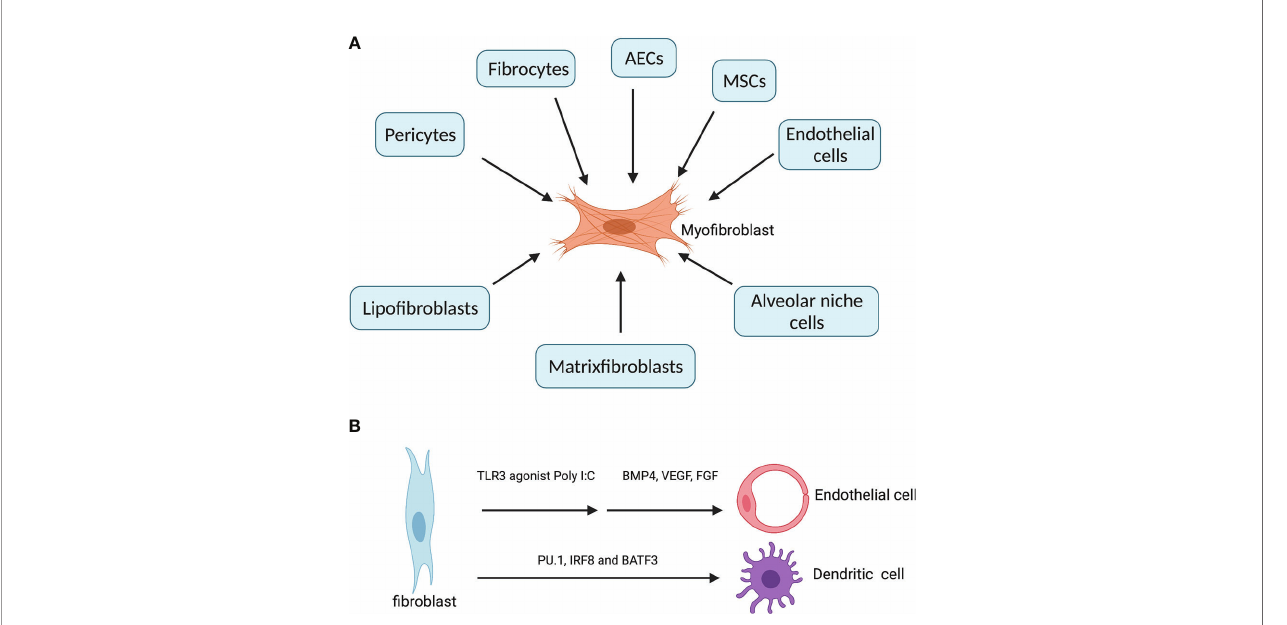
FIGURE 1 | Diverse origins of myo fi broblasts and transdifferentation of fi broblast. (A) In fi brosing ILDs, the effector myo fi broblasts can be derived from three other resident fi broblasts (lipo fi broblasts, matrix fi broblasts and alveolar niche cells), pericytes (residing within basal membranes or perivascular linings), hematopoietic CXCR4 + fi brocytes, alveolar epithelial cells (AECs), endothelial cells (ECs) and mesenchymal stem cells (MSCs) (14). (B) fi broblasts can transdifferentiate into endothelial cells when treated with innate immune agonist Poly I:C and growth factors BMP4, VEGF and FGF. Fibroblasts overexpressing PU.1, IRF8 and BATF3 simultaneously can be reprogrammed into functional dendritic cells. Created with